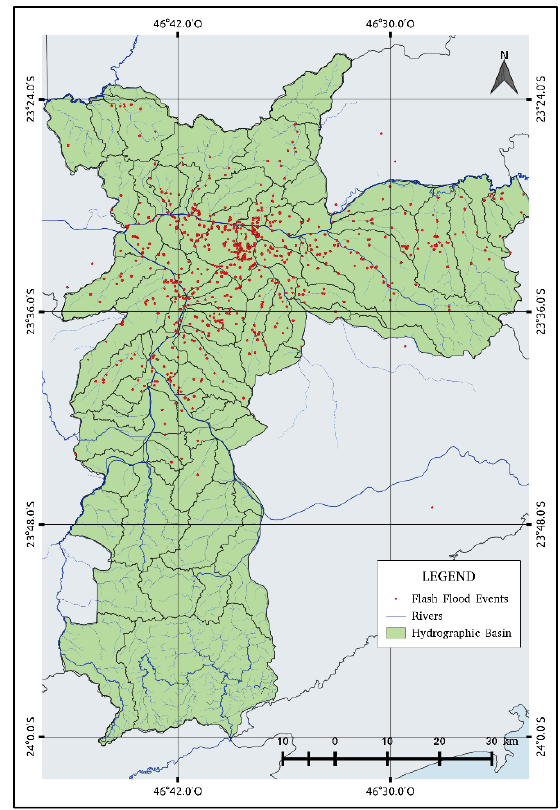
Figure 2. Total number of flash flood warning sites in Sao Paulo city.